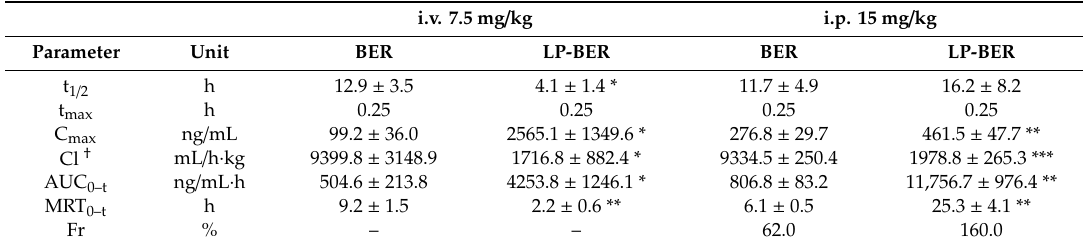
Table 5. Pharmacokinetic parameters of free BER and LP-BER in BALB / c mice after i.v. or i.p. administration at 7.5 or 15 mg / kg, respectively. Data expressed as mean ± SD (n =